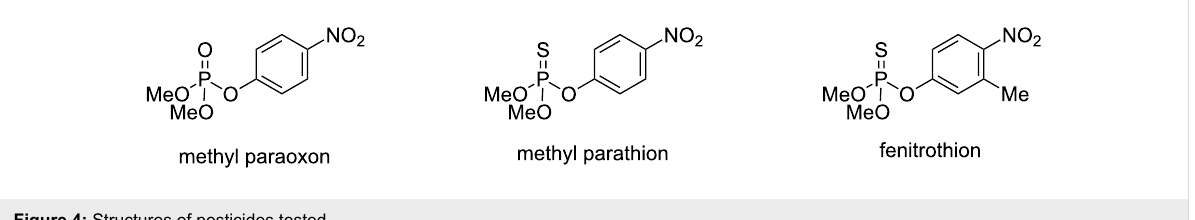
Figure 4: Structures of pesticides tested.